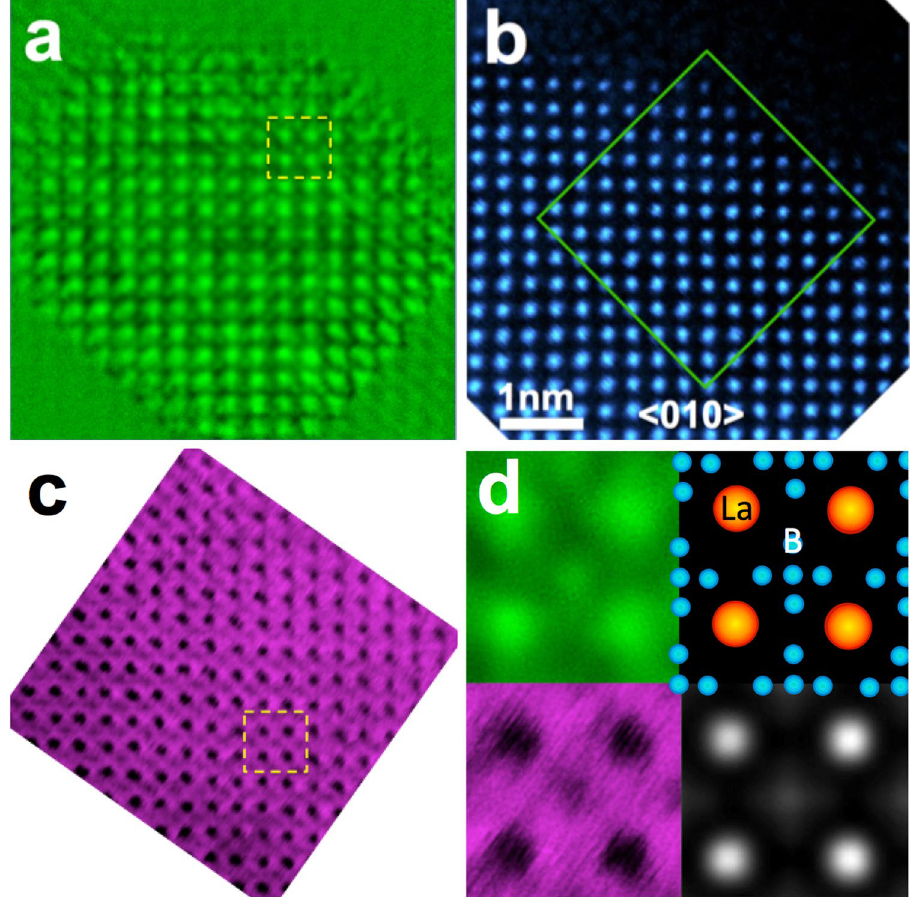
Figure 4. ( a ) Phase of the ptychographic reconstruction for a < 010 > orientation of a LaB 6 nanoparticle (total dose 0.94 × 10 8 e − nm − 2 ). ( b ) HAADF image from the same region. ( c ) ABF image from a similar nanoparticle to that shown in ( a ) and ( b ) (total dose 2.1 × 10 8 e − nm − 2 ). ( d ) Enlarged images (Top-left) and (Bottom-left) extracted from the regions indicated with yellow dashed squares in ( a ) and ( c ), respectively together with projected atomic models of the LaB 6 structure along a < 010 > direction (Top-right) and the phase reconstructed from simulated diffraction patterns